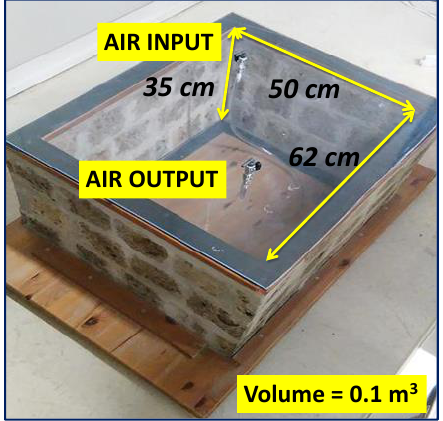
Figure 1. The Scale Model Room. Modified after [6].